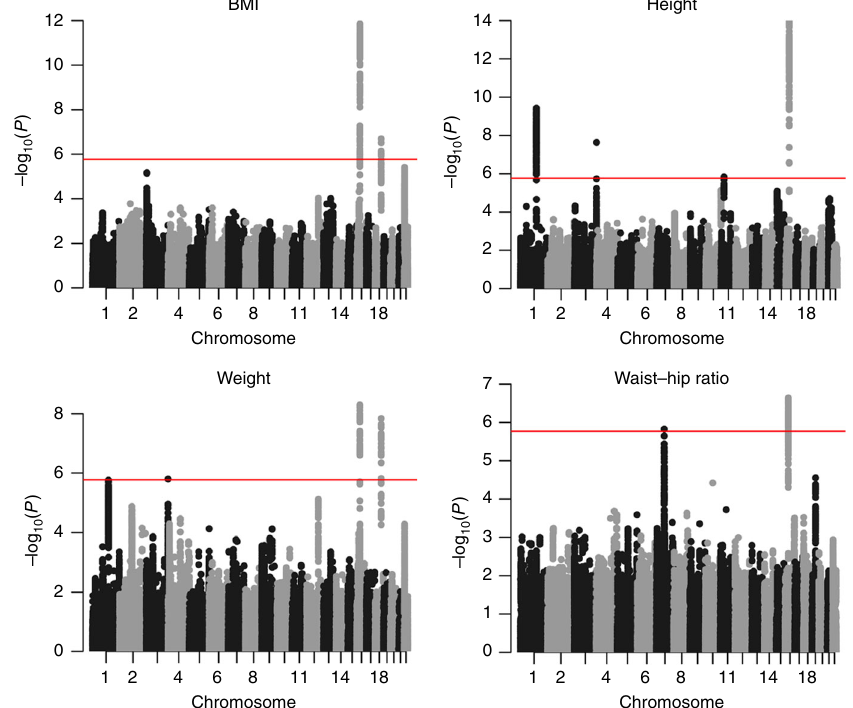
Fig. 1 Genome-wide Manhattan plots for four anthropometric traits. Genome-wide association study for CNVs associated with BMI, height, weight, and waist-to-hip ratio in 191,161